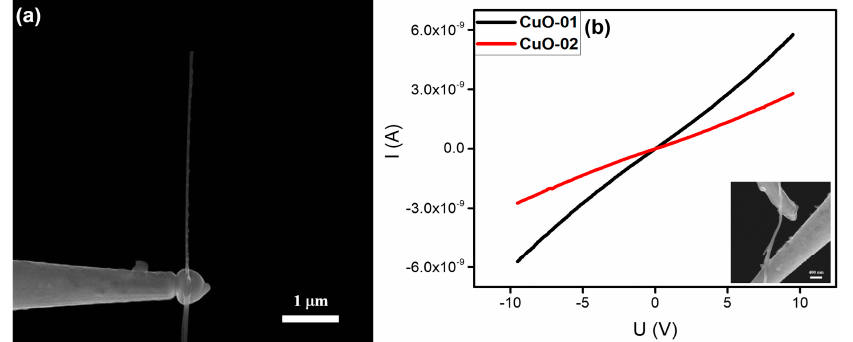
Figure 6. ( a ) SEM image of an individual CuO nanowire welded onto a tungsten needle. ( b ) Typical current versus voltage (I ‒ V curves) of two individual CuO nanowires. Typical SEM image of the in-situ electrical measurement is given as an inset.